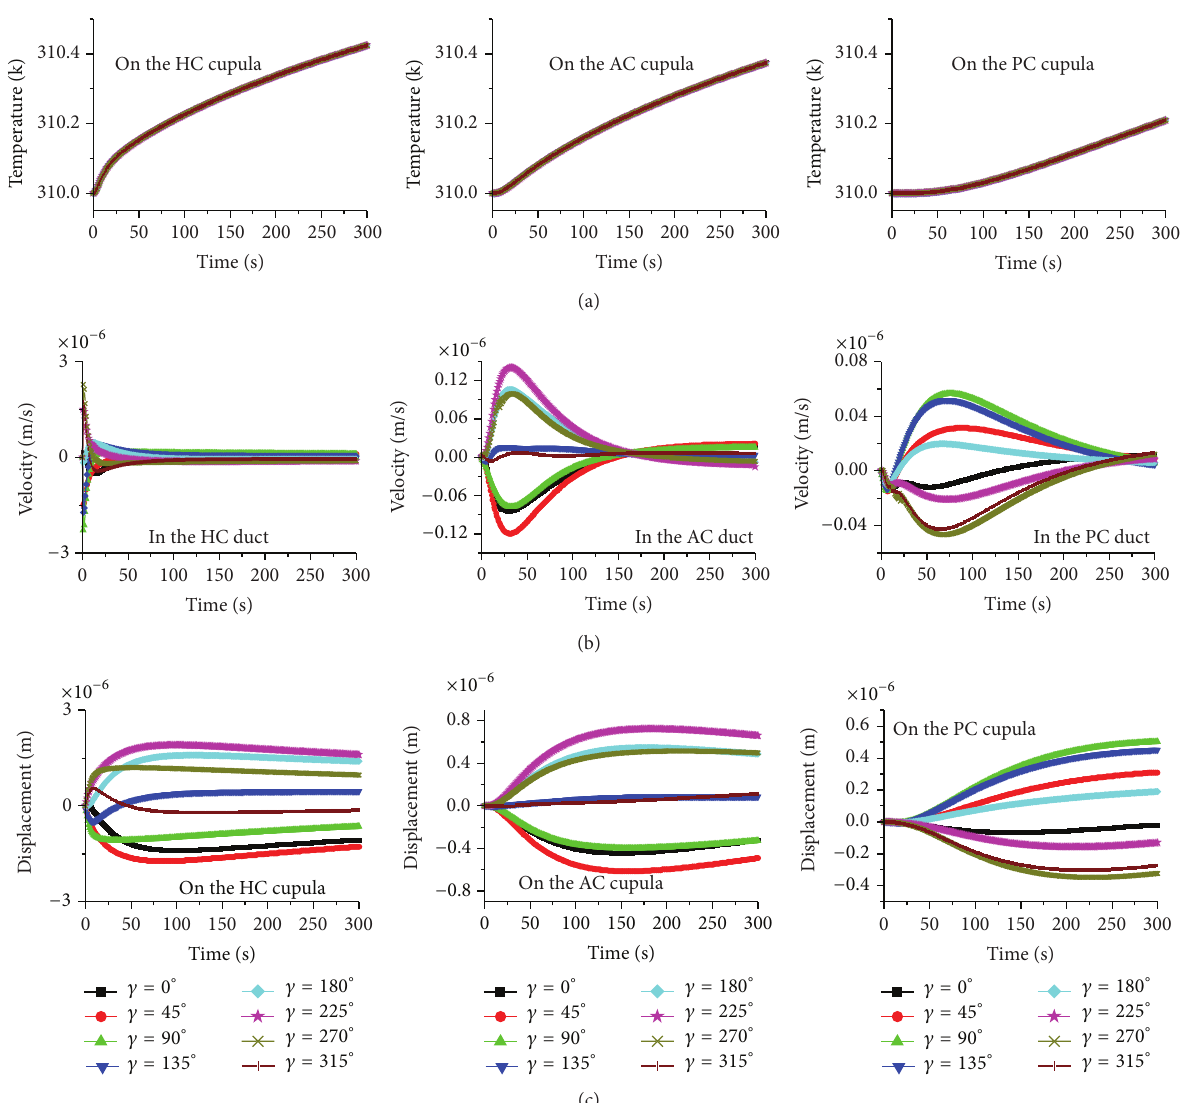
Figure 6: The effects of head position on the caloric responses when the gravity is parallel to the plane 𝛾 . (a) Temperature, (b) endolymph velocity, and (c) cupula